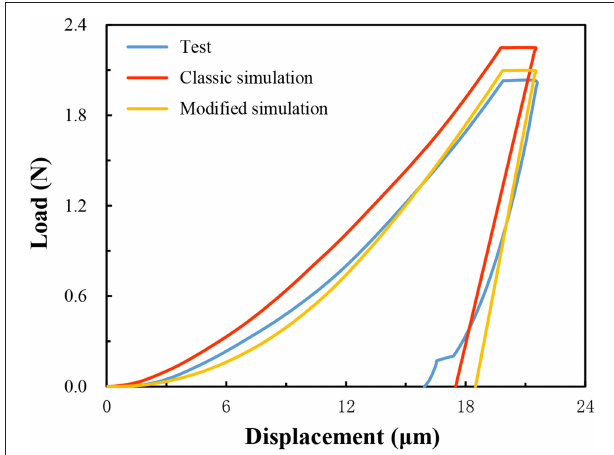
FIGURE 5 | Comparison of the load-displacement curves of P 14 indentation point between experimental results and simulation results.